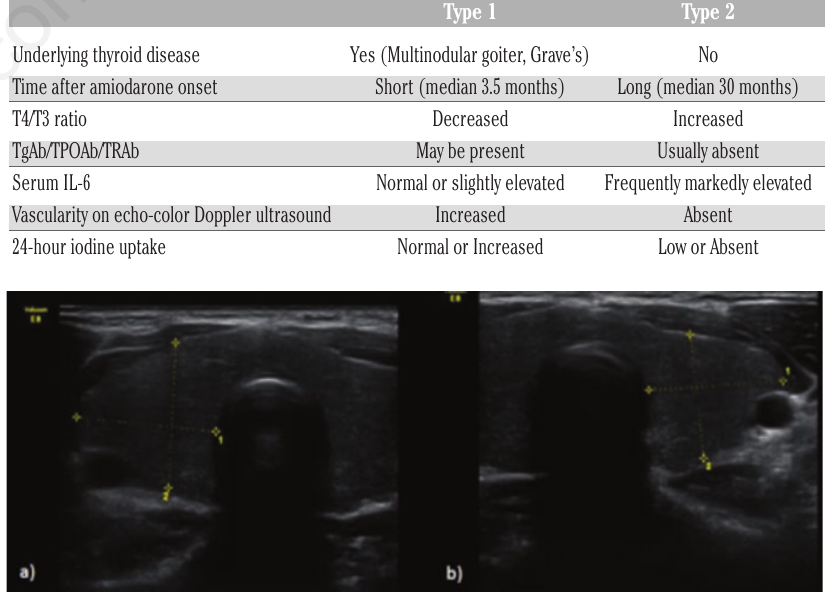
Figure 1. Thyroid ultrasound (24/10/2017): thyroid with globally hypoechogenic tex- ture, with no solid nodules; no increase in vascularization; no latero-cervical adenopathies. a) Thyroid right lobe; b) Thyroid left